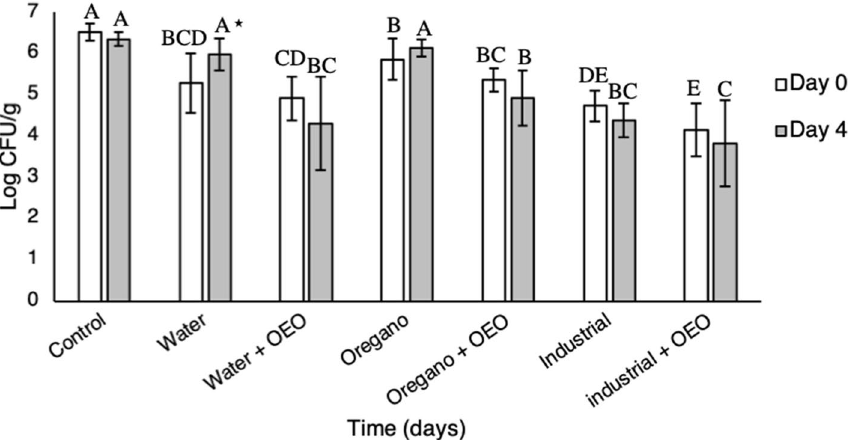
Figure 3. Effect of 3-h marination on the survival of S. Typhimurium FS8 on pork meat. Hydro-distilled oregano extract and industrial oregano hydrolate supplemented with or without 0.2% oregano essential oil (OEO) were used as marination solutions. Water and inoculated untreated pork meat samples were used as controls. Samples were stored at 4 °C. Sampling was performed immediately after treatment (white bars) and after 4 days of storage (grey bars). Bars represent an average (± standard deviation) of six replicates. Different capital letters indicate statistical differences ( P < 0.05) among different treatments of the same storage time according to Tukey’s HSD. Star indicate statistical differences ( P < 0.05) between identically treated samples during 0 and 4th day of storage according to t-test